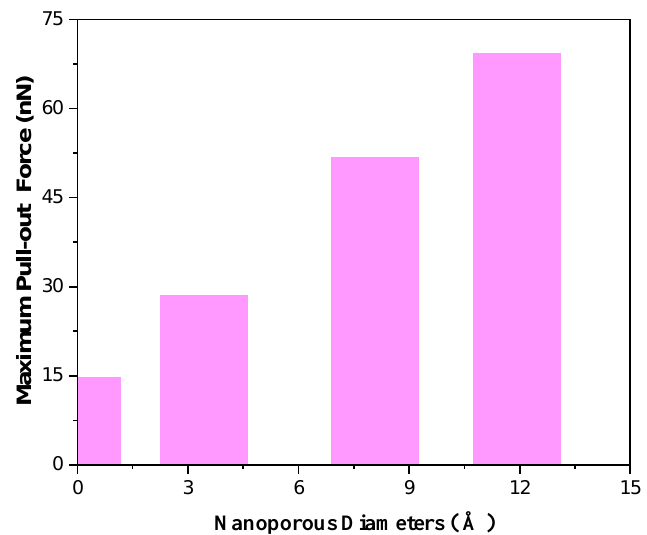
Figure 7. The maximum pull-out force changes vs. nanoporous diameters.